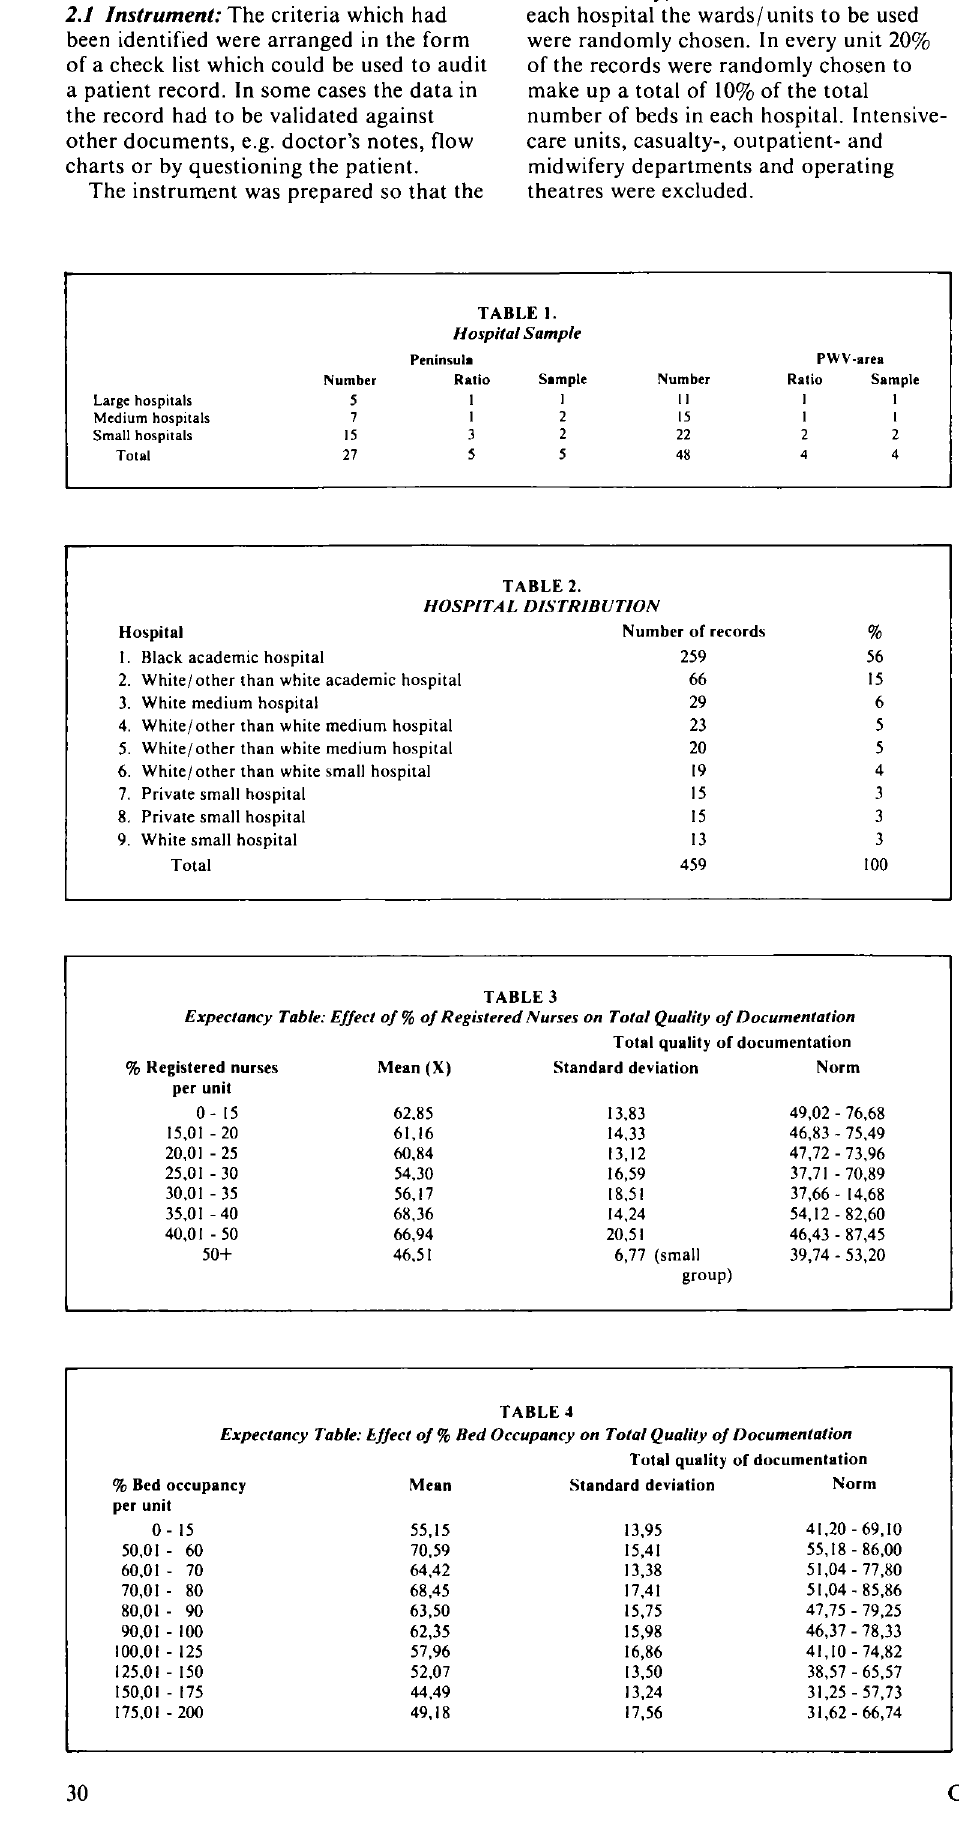
TABLE 1. Hospital Sample